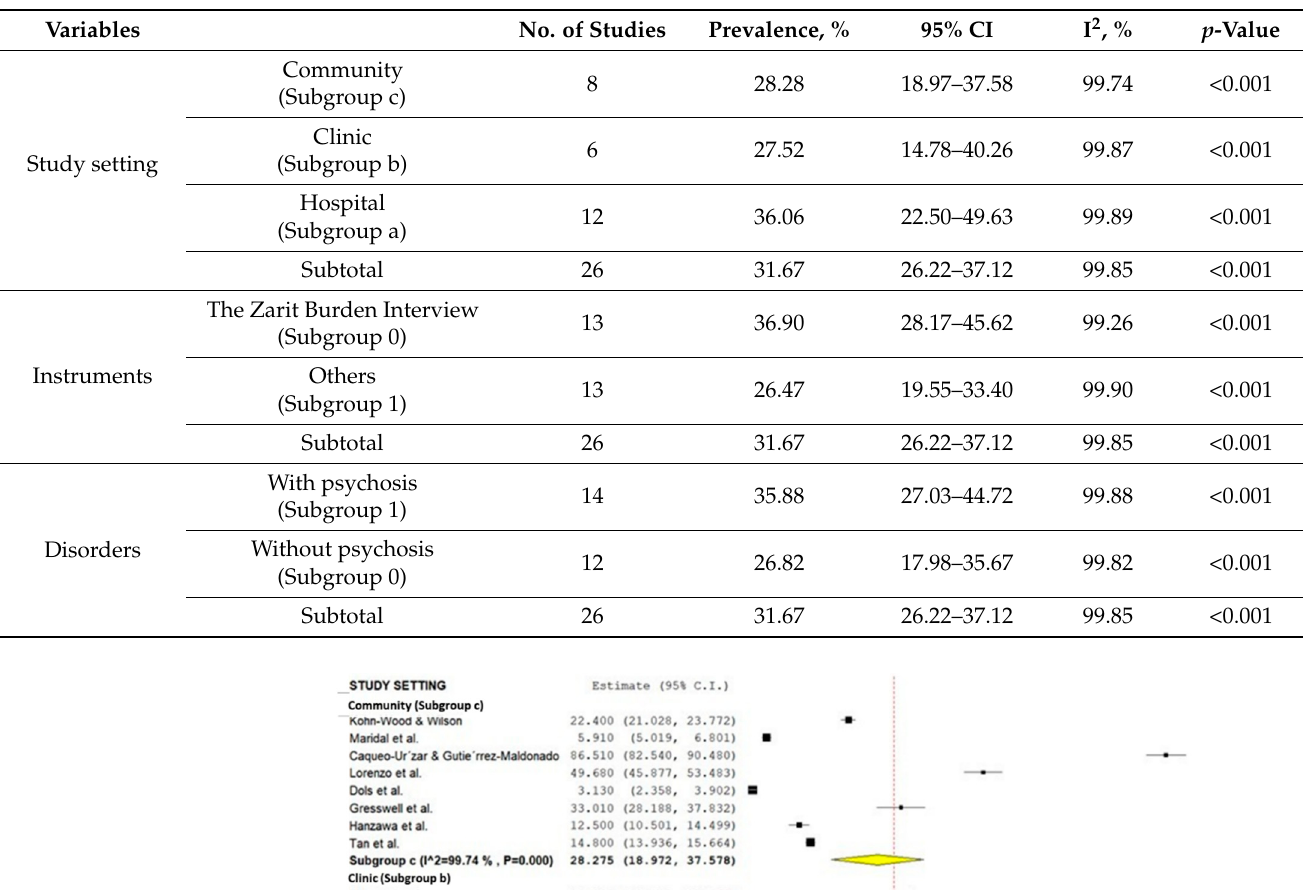
Table 2. Subgroup analysis of pooled prevalence of caregiver burden among caregivers of patient with mental illness.